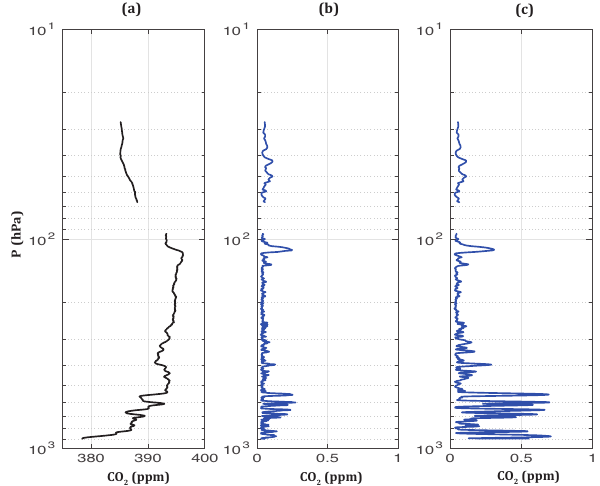
Figure 10. (a) AirCore-HR CO 2 vertical profile, (b) CO 2 uncer- tainty without taking the potential loss of air into account (see Sect. 4.2, point v) and (c) overall CO 2